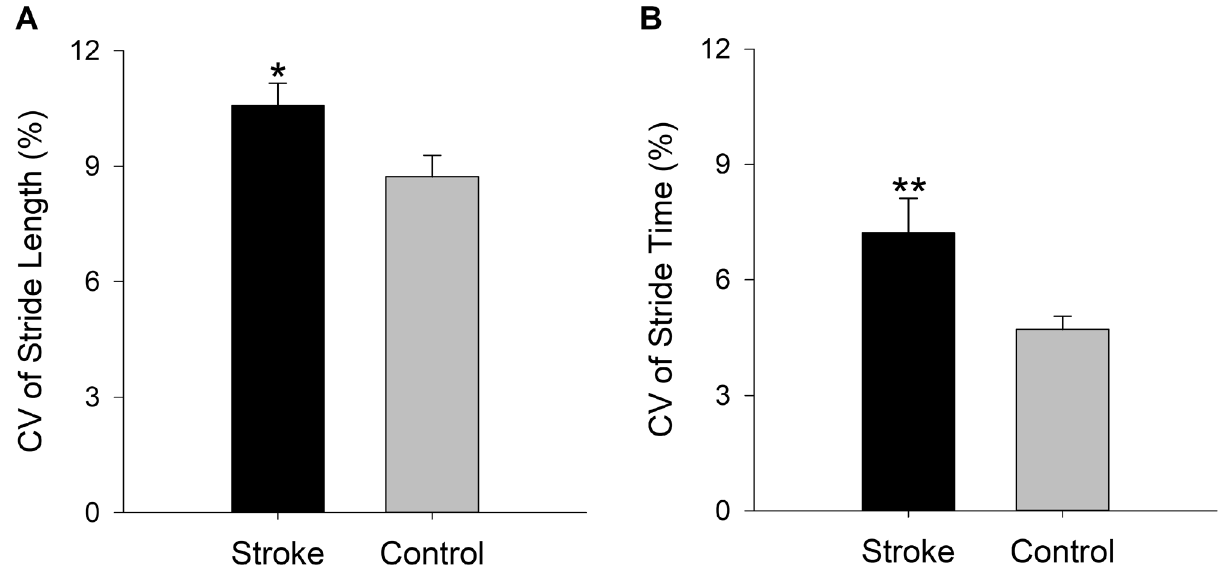
Figure 1. The impact of stroke on spatial and temporal gait variability: The gait variability measures were averaged across the two legs. The stroke group showed increased stride length variability ( A ) and increased stride time variability ( B ) compared with the control group. * p < 0.05. ** p <